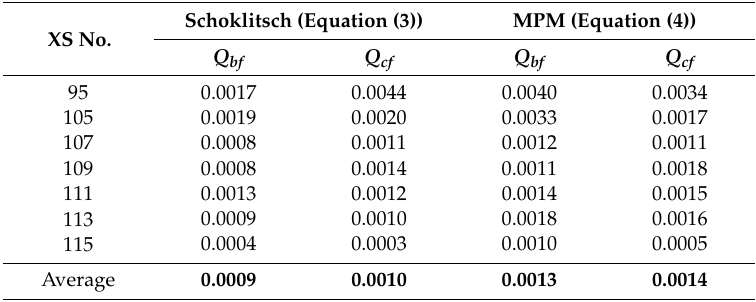
Table 2. The estimated stable channel slopes at different cross-sections in the study reach.